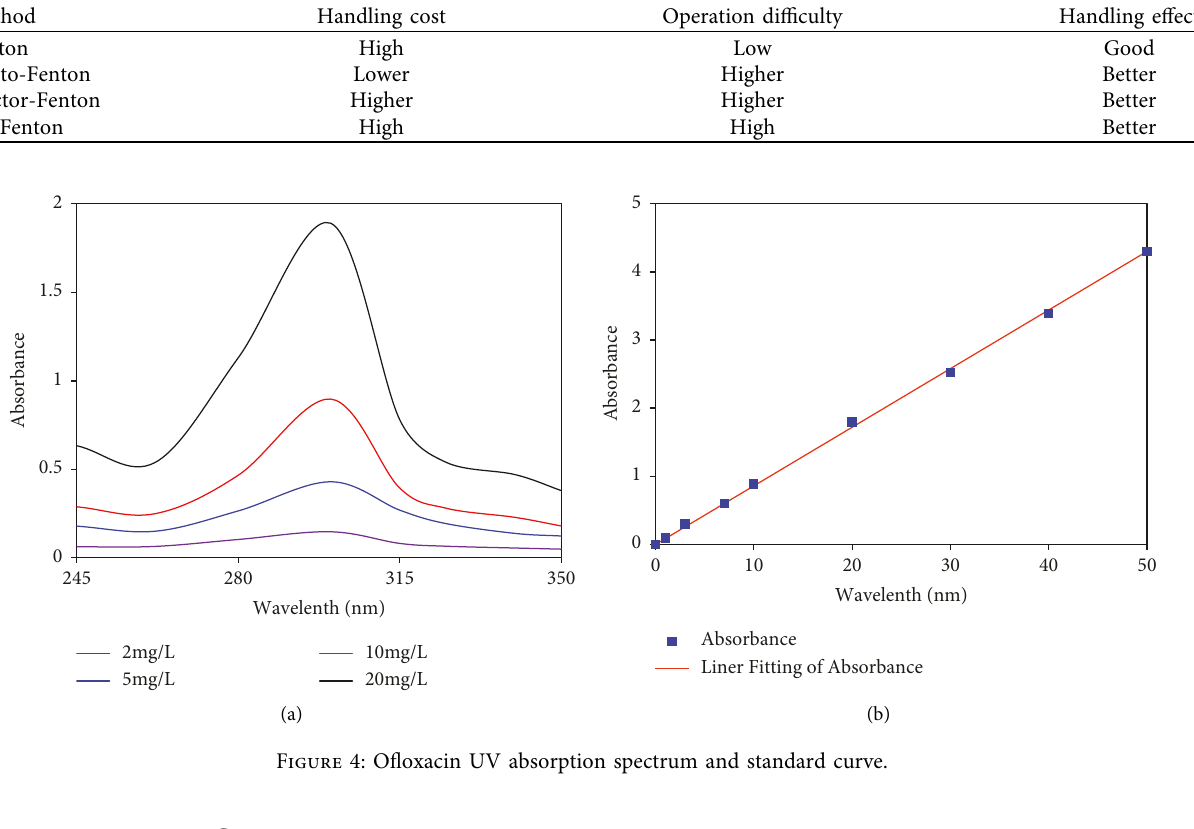
Figure 4: Ofloxacin UV absorption spectrum and standard curve.